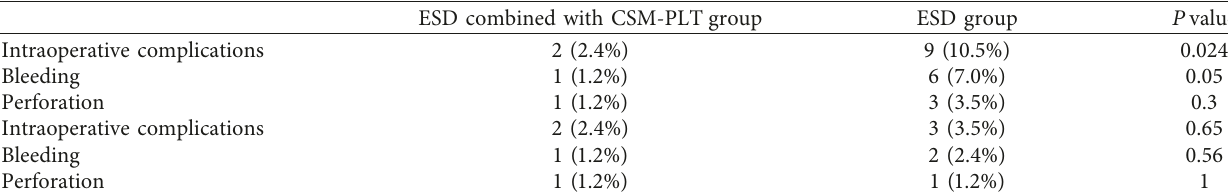
Table 3: Perioperative